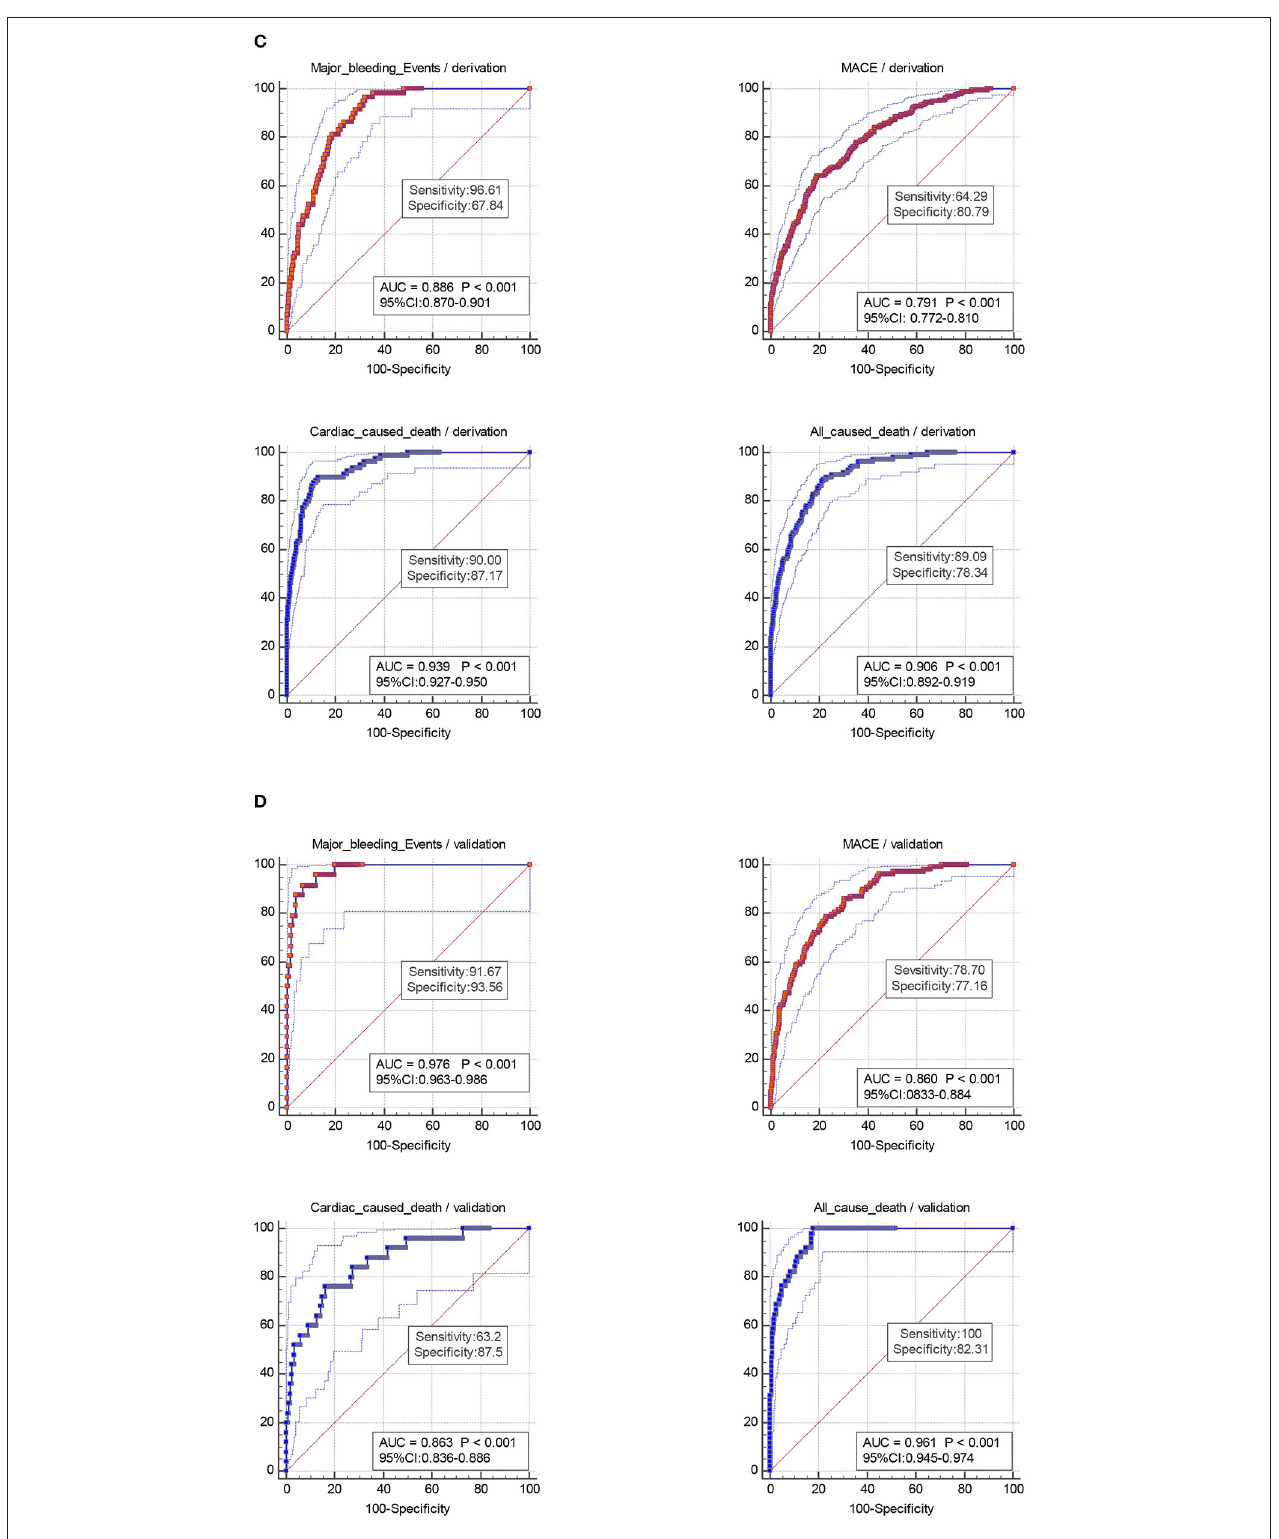
FIGURE 3 | (A) ROC curve of thrombotic events ( p < 0.001), MACEs ( p < 0.001), cardiac-caused death ( p < 0.001), and all-caused death ( p < 0.001) according to the thrombotic risk score categories in the derivation cohort ( N = 2,084). (B) Cumulative 3-year incidence of thrombotic events ( p < 0.001), MACEs ( p < 0.001), cardiac-caused death ( p < 0.001), and all-caused death ( p < 0.001) according to the thrombotic risk score categories in the validation cohort ( N = 892).